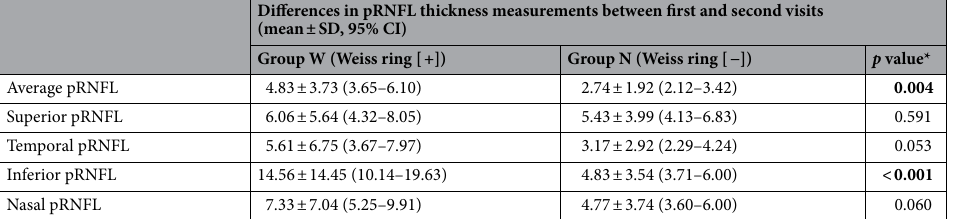
Table 5. Comparisons of differences in average and sectoral peripapillary retinal nerve fiber layer (pRNFL) thickness at the first and second visits. SD standard deviation, CI confidence interval. * p value for the differences in pRNFL thickness measurements between groups W and N using the independent t -test. Significant values are in bold.